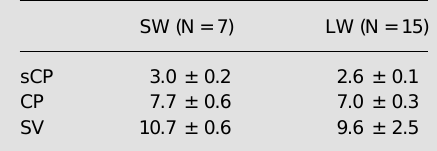
(SV) of rats multifocally inoculated with Walker 256 tumor, sham-operated (SW; N = 7) and sep- tal-lesioned (LW; N = 15). The values are reported as the means ± SEM for the number of rats indicated by